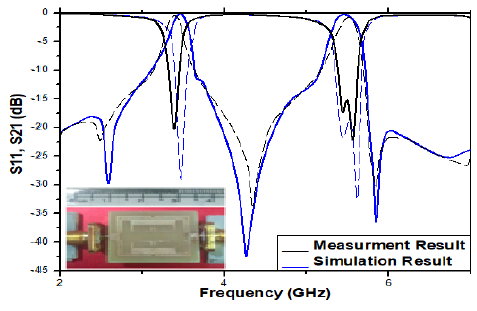
FIGURE 12. Fabricated prototype and comparison of Simulated and measured frequency responses From Figure 9 we can calculate the Fractional Bandwidth (FBW) of the dual pass bands. When the value of d1 varies, center frequencies of both the pass bands changes and hence the FBW. When d1=0.59mm, the new pair of dual pass band center frequencies will be generated (Figure 10), which will have different FBW. The External Quality factor (Q e ) may be defined as [21] (9)